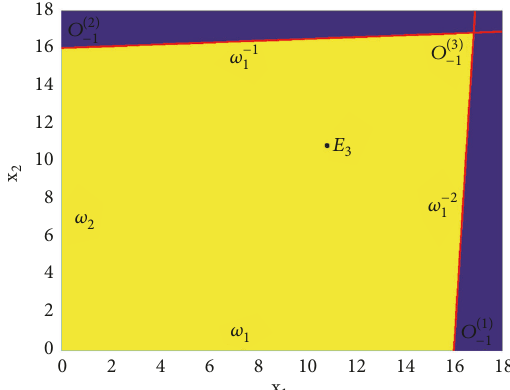
Figure 8: Basin of attraction of system (17). The yellow region is the basin of attraction of the Nash equilibrium point 𝐸 3 , and the dark blue region represents domain of escaping. 𝑂 1 −1 , 𝑂 2 −1 , and 𝑂 3 −1 are the rank-1 preimages of the origin 𝑂 = (0,0) ; 𝜔 −1 1 and 𝜔 −1 2 are the rank-1 preimages of 𝜔 1 and 𝜔 2 . The boundaries of attracting domain of 𝐸 3 are constituted by these